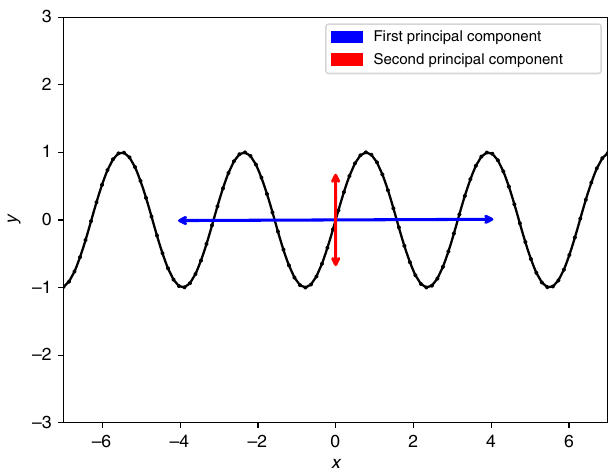
Fig. 1 PCA decomposition of the data generated from sinusoidal function. Datapoints on the plot are drawn at uniform interval from parametric equations x ( t ) = t and y ( t ) = sin(2 t ), where t ranges from − 7 to 7. The blue bidirectional line represents the fi rst Principal Component, which explains 98% of the variance in the data. The red bidirectional line represents the second Principal Component, which explains the rest of the variance in the